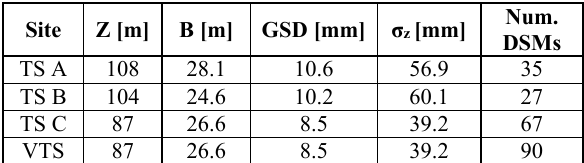
Table 2. Geometric characteristics and estimated precision of image blocks for all test